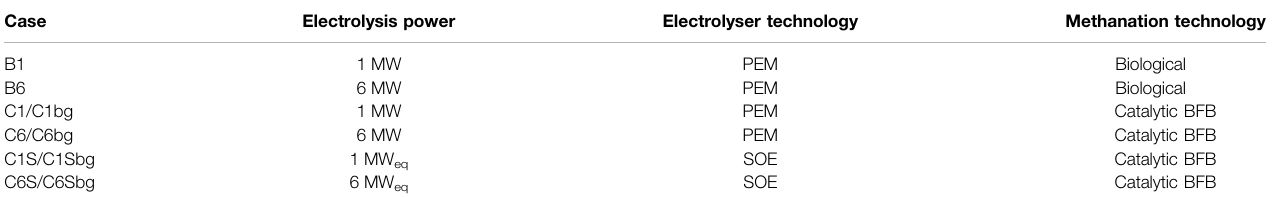
TABLE 1 | Power-to-Gas process chains for CO 2 methanation considered in this study. The processes abbreviated with a “ B ” refer to the biological methanation, those abbreviated with “ C ” to the catalytic case. The numbers indicate the 1 MW and 6 MW-scale respectively. The variations marked with “ bg ” use biogas as feed instead of pure CO 2 . The processes based on SOE instead of PEM electrolysis are indicated with “ S ” .